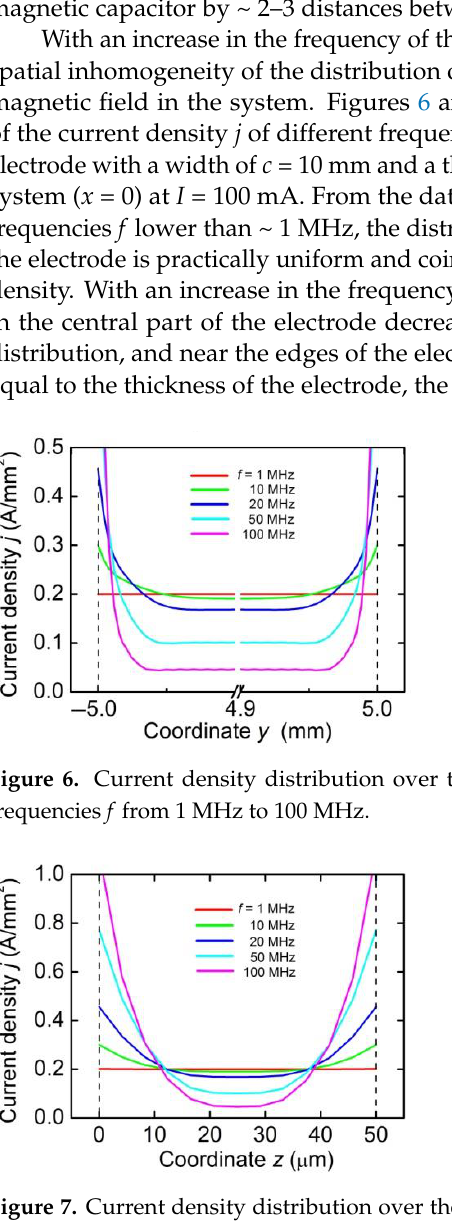
Figure 5. Distribution of the magnetic field h y along the width inside the "magnetic capacitor" for I = 100 mA and z = 0.